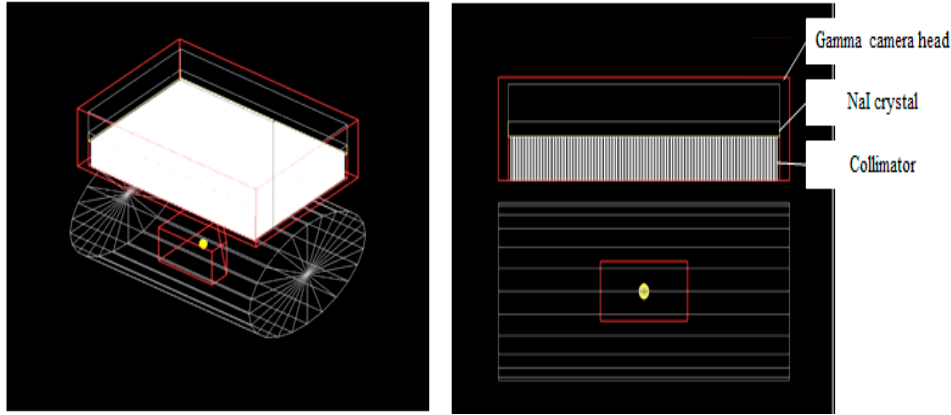
Figure 4. Geometry setup of gamma camera and phantom. Yellow dots represent the tumour. Table 1. Characteristics of collimators used for 159 Gd and 99m Tc.